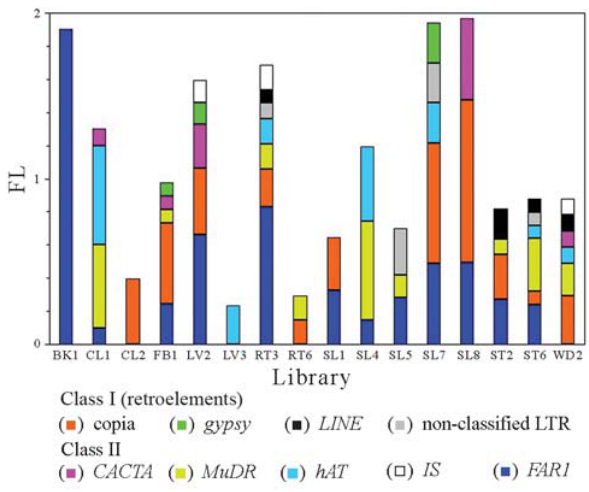
Figure 2 - Frequency of TE in different Eucalyptus libraries (FL). Values in Table 2 were converted to frequency values within each of the libraries as described in the text. Libraries LV1, SL6 and ST7 did not contain TE and therefore were not represented. Individual contribution of each of the groups of TE for the FL values are represented by different